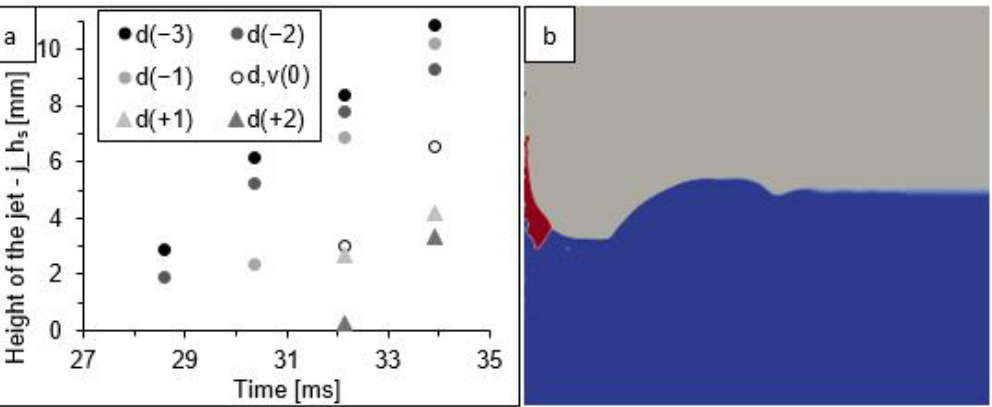
Figure 7. A jet: ( a ) changes in the jet height in a function of time for six models of size variants; ( b ) an example of jet simulation at 34 ms for model d,v(0) — the colours signify: water (blue), petrol (red), and air (grey).